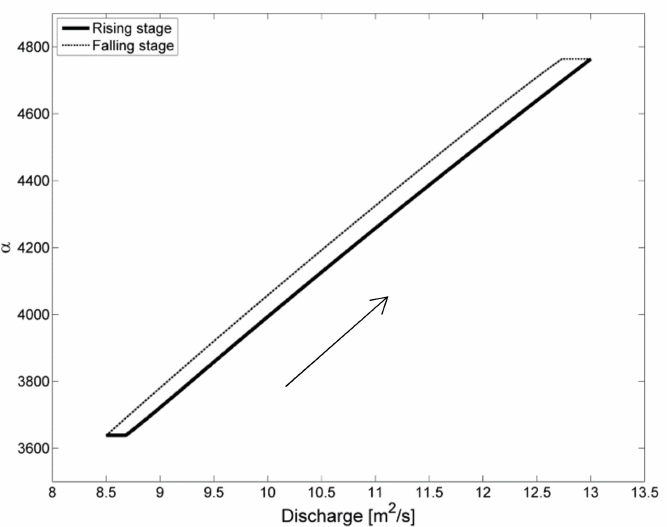
Figure 15. Specific discharge versus non-dimensional step length α separated for the rising and falling stages of the hydrograph, using the river scenario. The arrow signifies the direction of development over